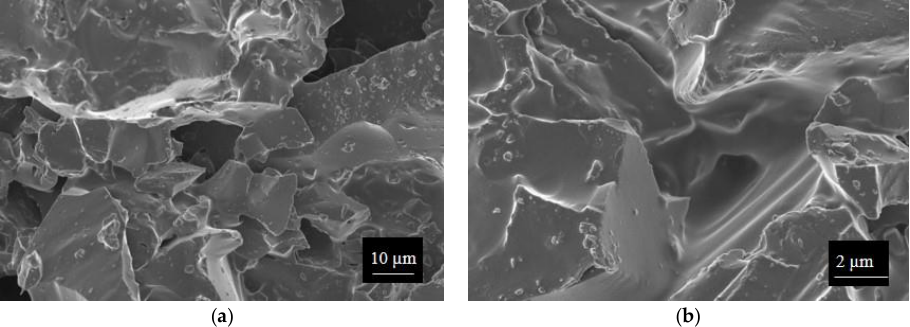
Figure 9. FESEM micrographs of SWP700-PVP20% sensor at different magnifications: ( a ) 2500×; ( b ) 10,000×.